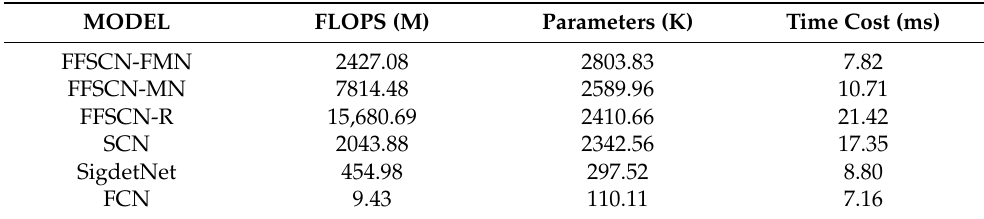
Table 4. The complexity comparison between the proposed FFSCN method and the other deep- learning-based methods.